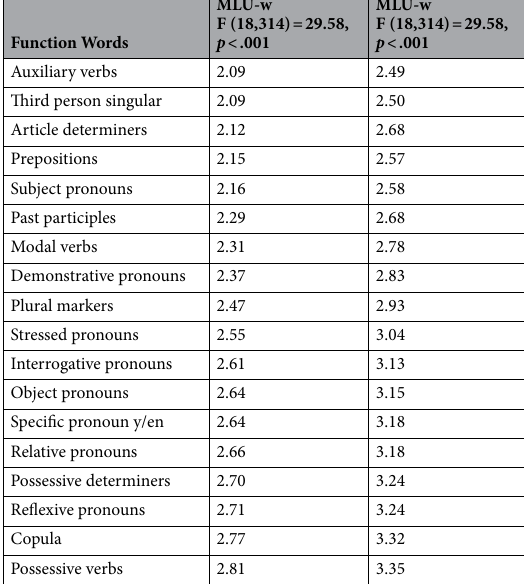
Table 3. Estimated MLU in words and in morphemes on Function Words.